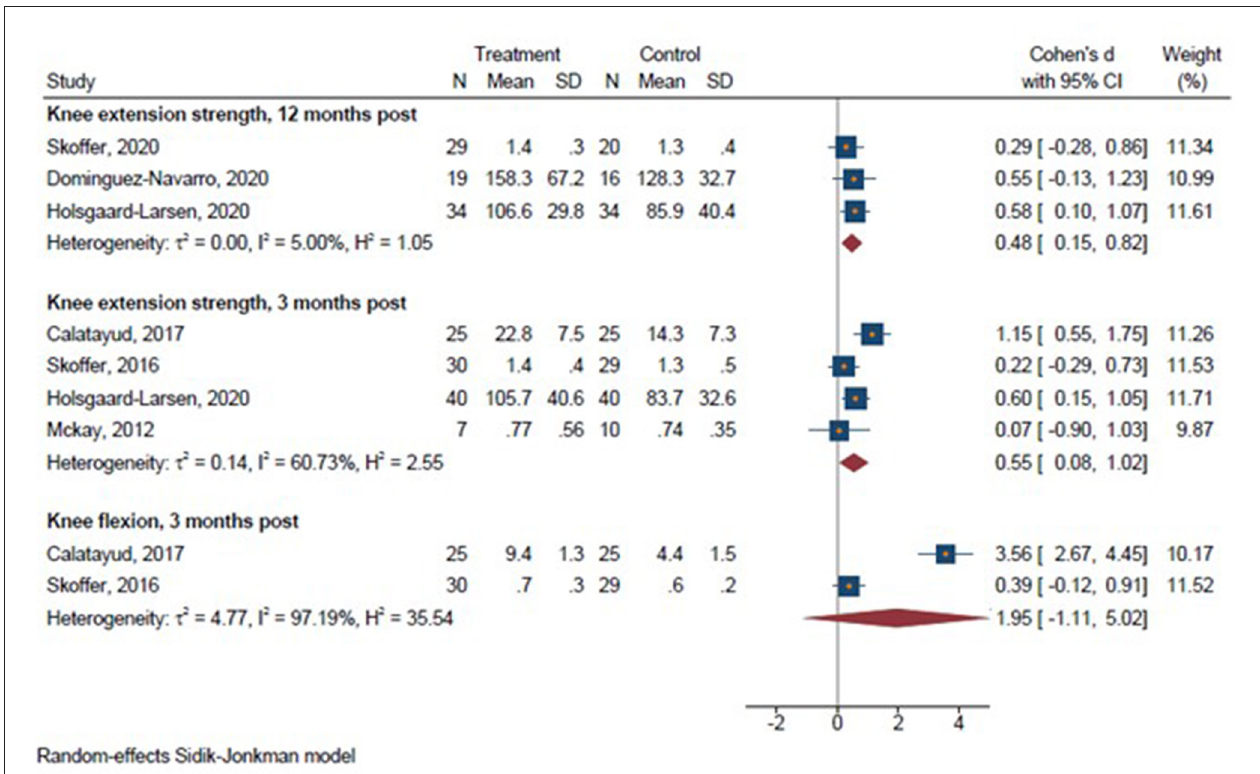
FIGURE 4 | Forrest plots on lower limb strength 3 and 12 months post-operatively. Forest plots of the results of a random-effects meta-analysis shown as standardized mean differences with 95% CIs on lower limb strength 3 and 12 months post-operatively. For each study, the blue square represents the point estimate of the intervention effect. The horizontal line joins the lower and upper limits of the 95% CI of this effect. The red diamonds represent the pooled mean difference for each